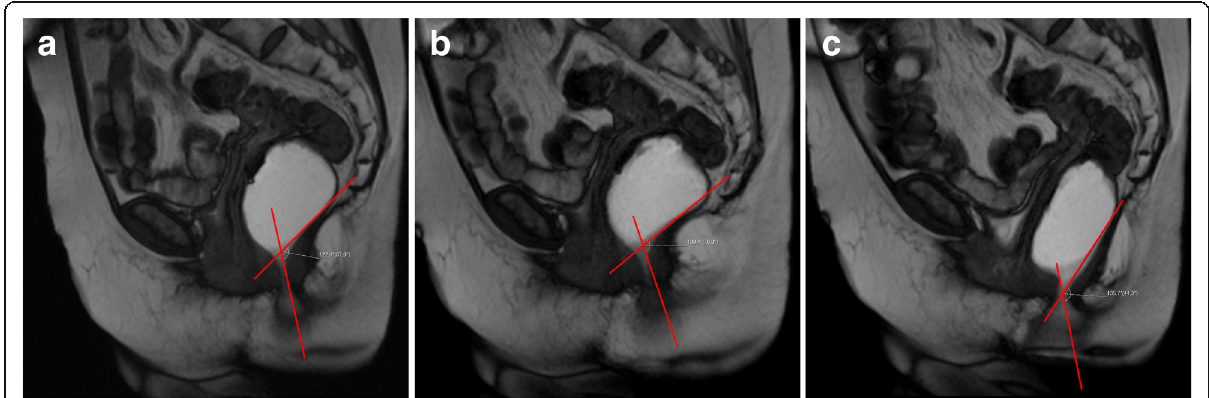
Fig. 8 Normal anorectal angles. ( a , b , c ) Sagittal midline TrueFISP images at rest ( a ), during squeezing ( b ), and evacuation ( c ), with normal measurements of the ARA: 122° ( a ); 109° ( b ); 137° ( c